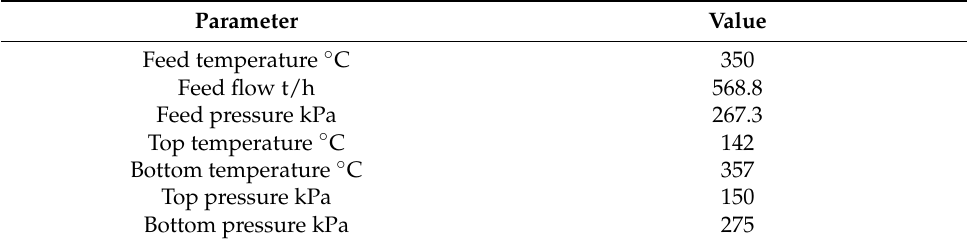
Table 3. Basic parameters of the atmospheric